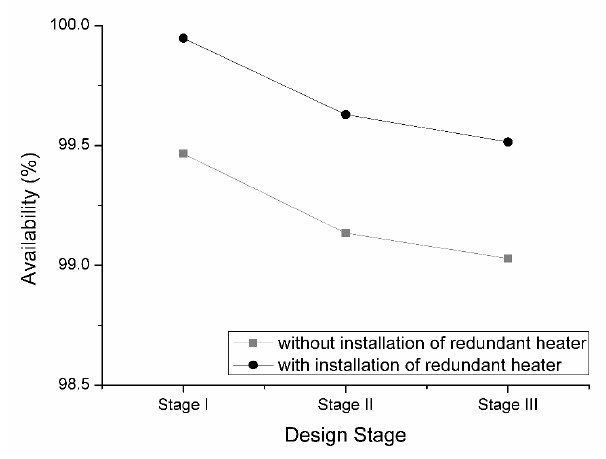
Figure 17. Availability with installation of redundant heater.